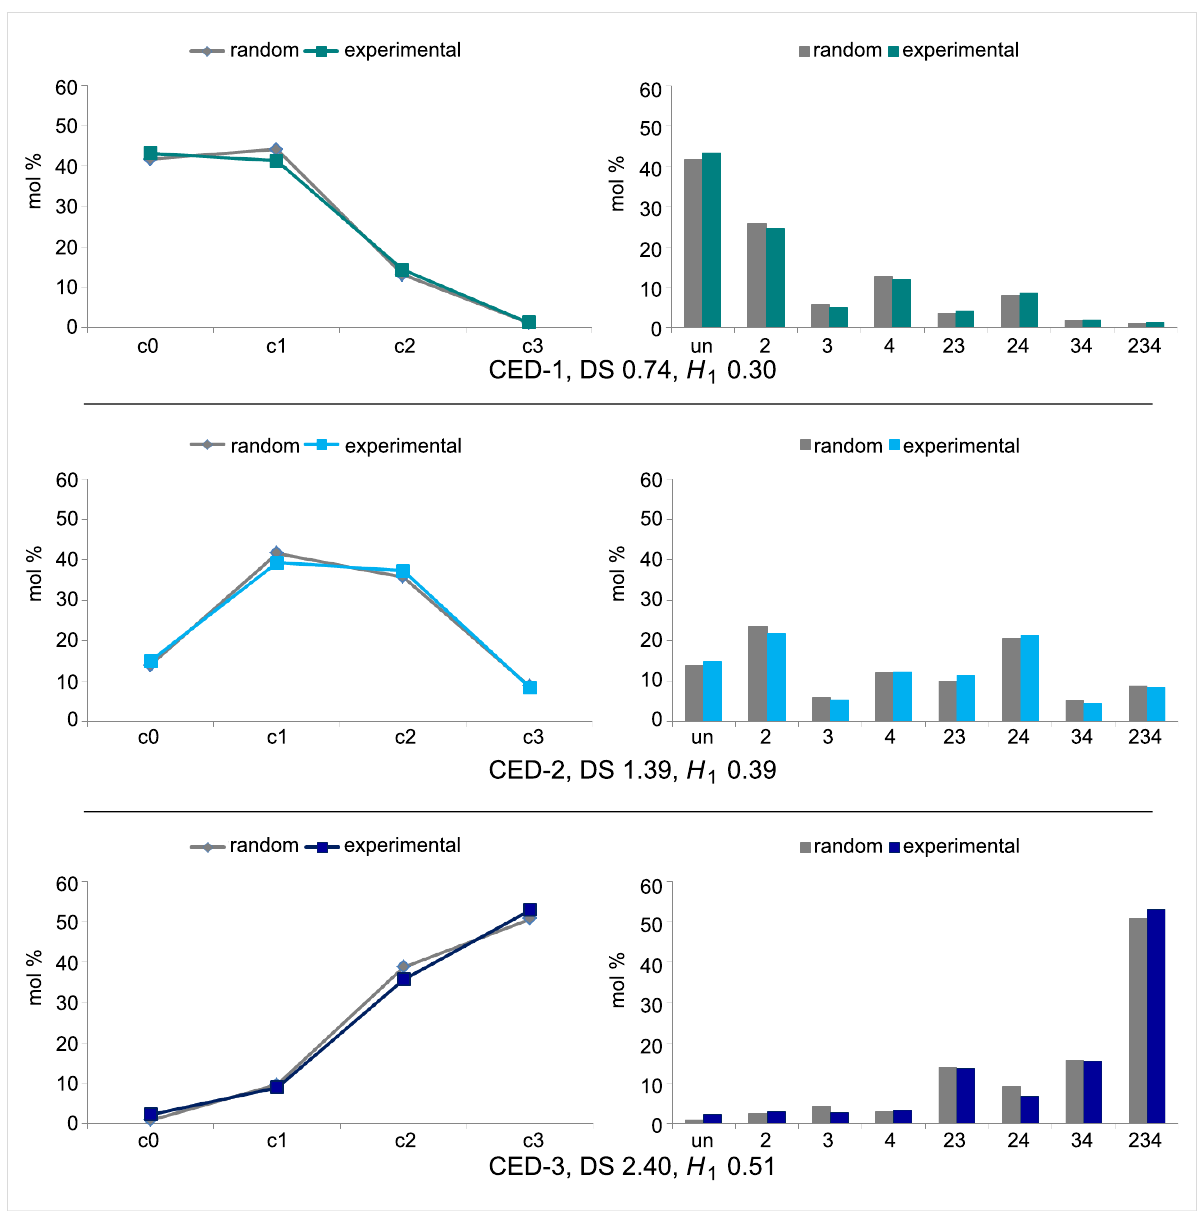
Figure 7: Experimentally determined substituent distribution in the glucosyl units (glc) of cyanoethyldextrans CED-1–3 (blue) compared with a random distribution (gray). Left: ci = the fraction of i-fold-substituted glucosyl units (mol %); right: un = unsubstituted glc; the numbers assign the substituted positions, e.g., 234 = 2,3,4-tri- O -cyanoethyl glc; H 1 heterogeneity parameter for the standard deviation as defined in Table 2.